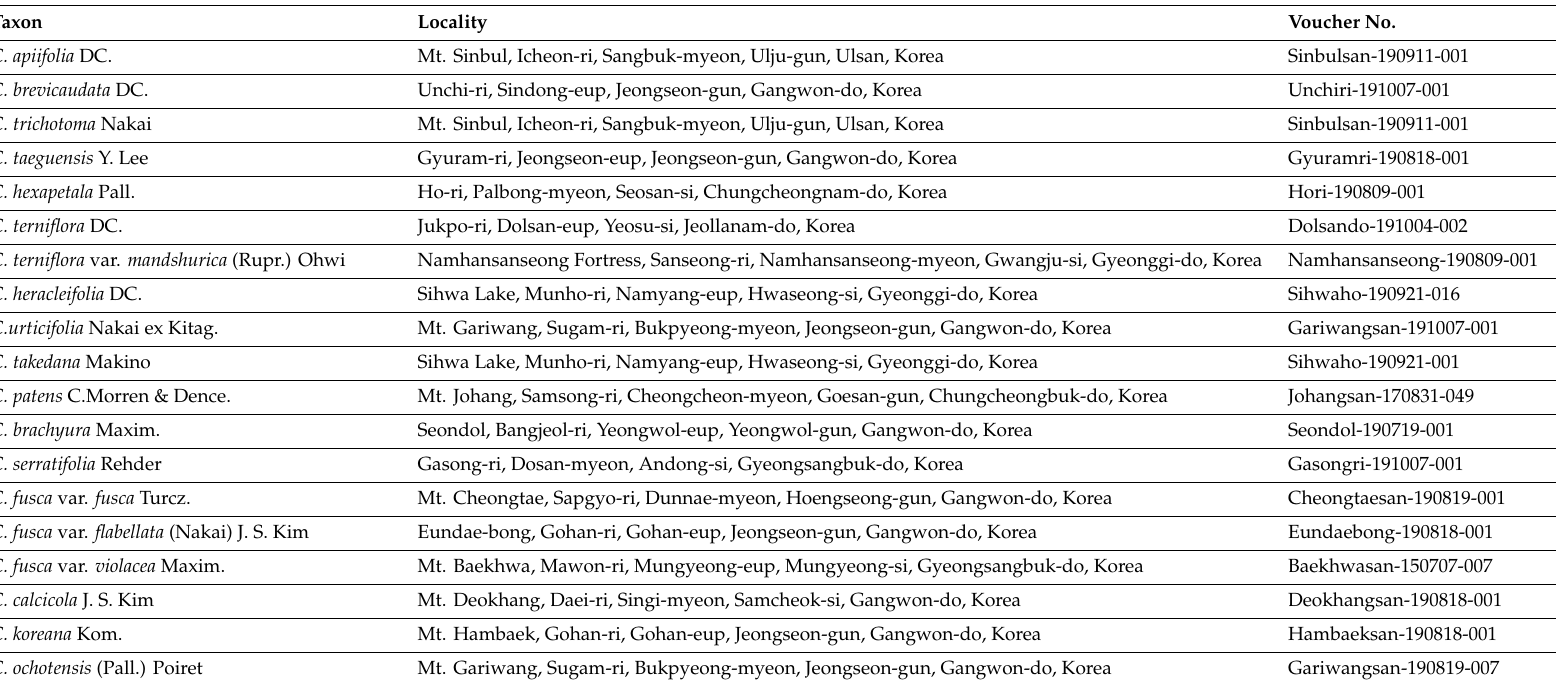
Table 1. Name of taxa with voucher number and collection